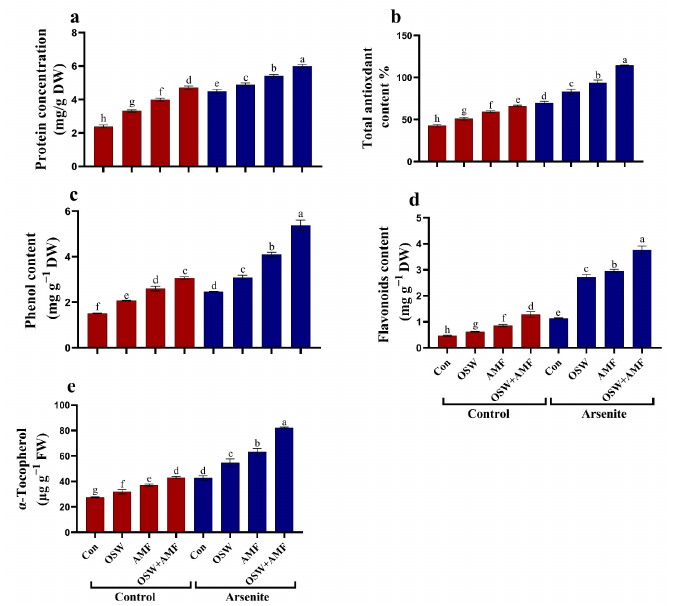
Figure 4. The influence of olive solid waste (OSW) and arbuscular mycorrhizal fungi (AMF), combination (OSW+AMF) on antioxidant metabolites (i.e., protein content ( a ), total antioxidant content ( b ), phenolics ( c ), flavonoids ( d ) , and α -tocopherol ( e )) in wheat plants growing under As III stress. Fishers test at p < 0.05 reveals significant variations in means (± standard deviation), which are different letters on the same bars. Plants 2023 , 12 , x